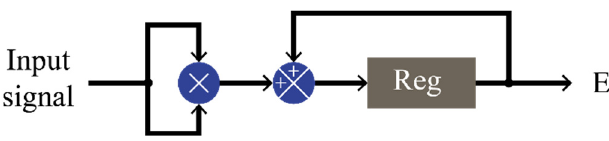
Figure 9. Energy Figure 9. Energy module.